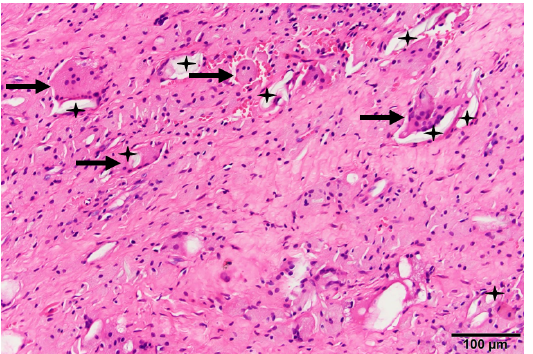
Figure 2. Histology of periprosthetic tissue with loosened metal on polyethylene total hip arthroplasty showing a number of multinucleated foreign-body giant cells (arrows), macrophages, and wear debris of polyethylene (stars). Hematoxylin-and-eosin staining.